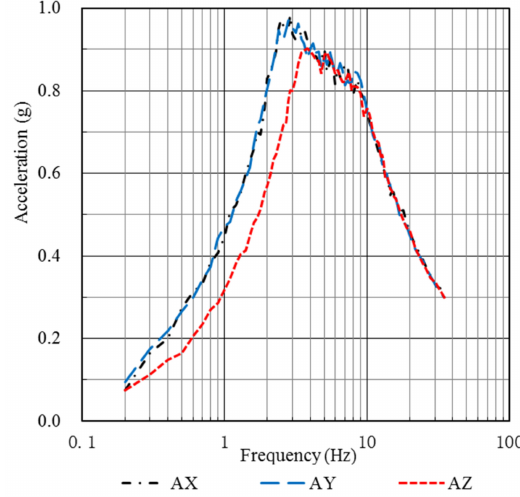
Figure 8. The acceleration response spectra of the input ground